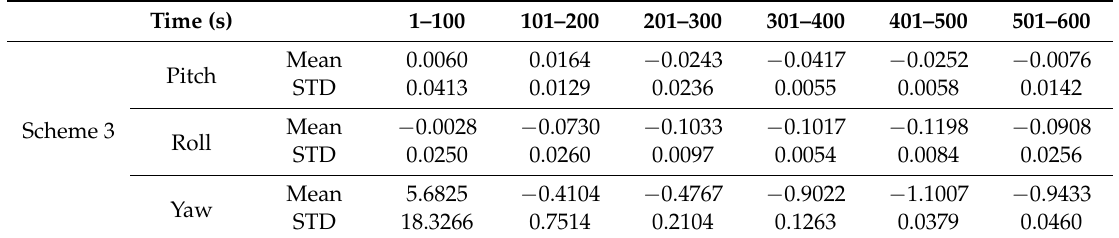
Table 9. The statistics of the alignment errors ( ◦